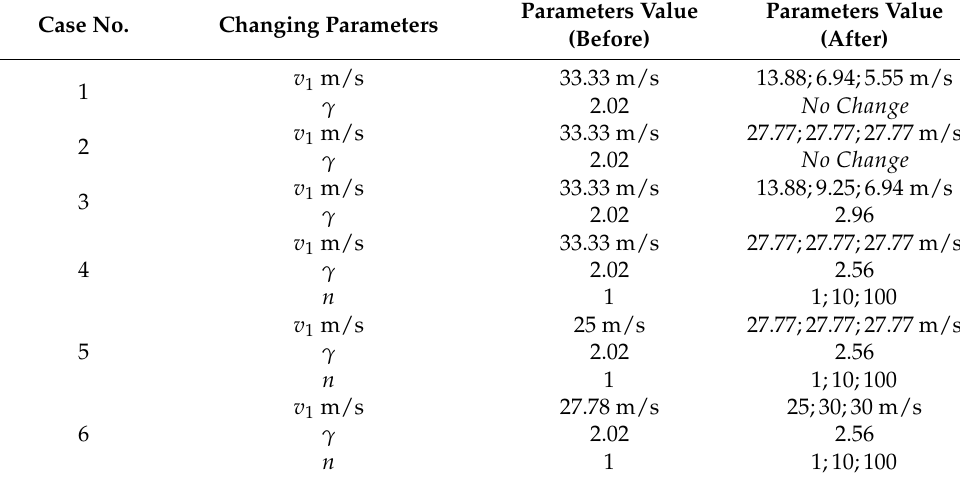
Table 4. Test cases used for